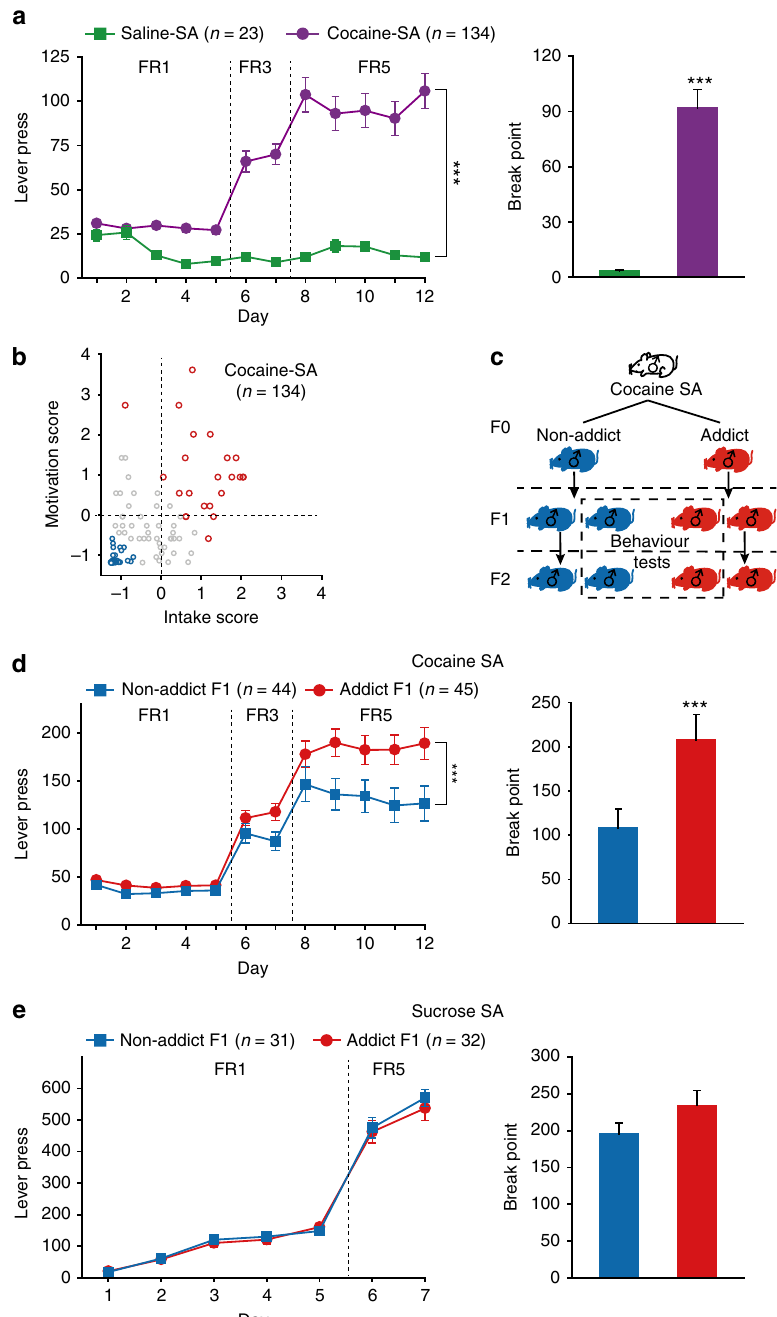
Figure 1 | Performance of Addict and Non-addict F0 rats in cocaine self-administration. ( a ) Naive rats were trained to self-administer saline (Saline SA) or cocaine (Cocaine SA) under a 5-day FR1, 2-day FR3, 5-day FR5, 1-day PR schedule. Cocaine-SA group showed higher lever presses at FR (left) and break point (right) at PR schedules, compared with Saline-SA group. Lever press, Group (cid:3) FR, mixed model repeated measures (MMRM), w 2 (2) ¼ 101.91, P o 0.001; Group, *** P o 0.001, Saline-SA versus Cocaine-SA. Break point, Mann–Whitney Rank-Sum Test, Z ¼ 4.688, *** P o 0.001. Saline-SA, n ¼ 23; Cocaine-SA, n ¼ 134. ( b ) Scores for cocaine intake and motivation of each Cocaine-SA rat were calculated according to SA performance at FR5 and PR schedules, respectively, and plotted. Cocaine SA rats with a combined drug-seeking behavioural score within the top 25% and the bottom 40% were designated as Addict F0 (red circle) and Non-addict F0 (blue circle), respectively. ( c ) Addict F0 and Non-addict F0 rats were crossed with naive female rats to generate Addict F1 and Non-addict F1, which were then randomly designated for mating to generate F2 or for behavioural testing. ( d ) Addict F1 rats displayed higher cocaine consumption and motivation than Non-addict F1. Lever press, Group (cid:3) FR, MMRM, w 2 (2) ¼ 23.33, P o 0.001; Group, P ¼ 0.041; FR5, *** P o 0.001, Non-addict F1 versus Addict F1. Break point, Mann–Whitney Rank-Sum Test, Z ¼ 3.272, *** P o 0.001. Non-addict F1, n ¼ 44; Addict F1, n ¼ 45. ( e ) There was no difference in intake and motivation for sucrose reward in F1. Lever press, Group (cid:3) FR, MMRM, w 2 (1) ¼ 10.1, P ¼ 0.32. Break